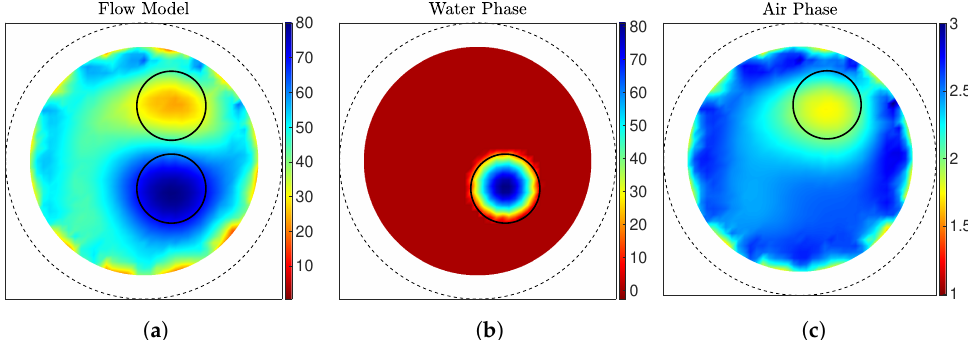
Figure 6. Reconstructed images from simulations of air and water bubbles dispersed in